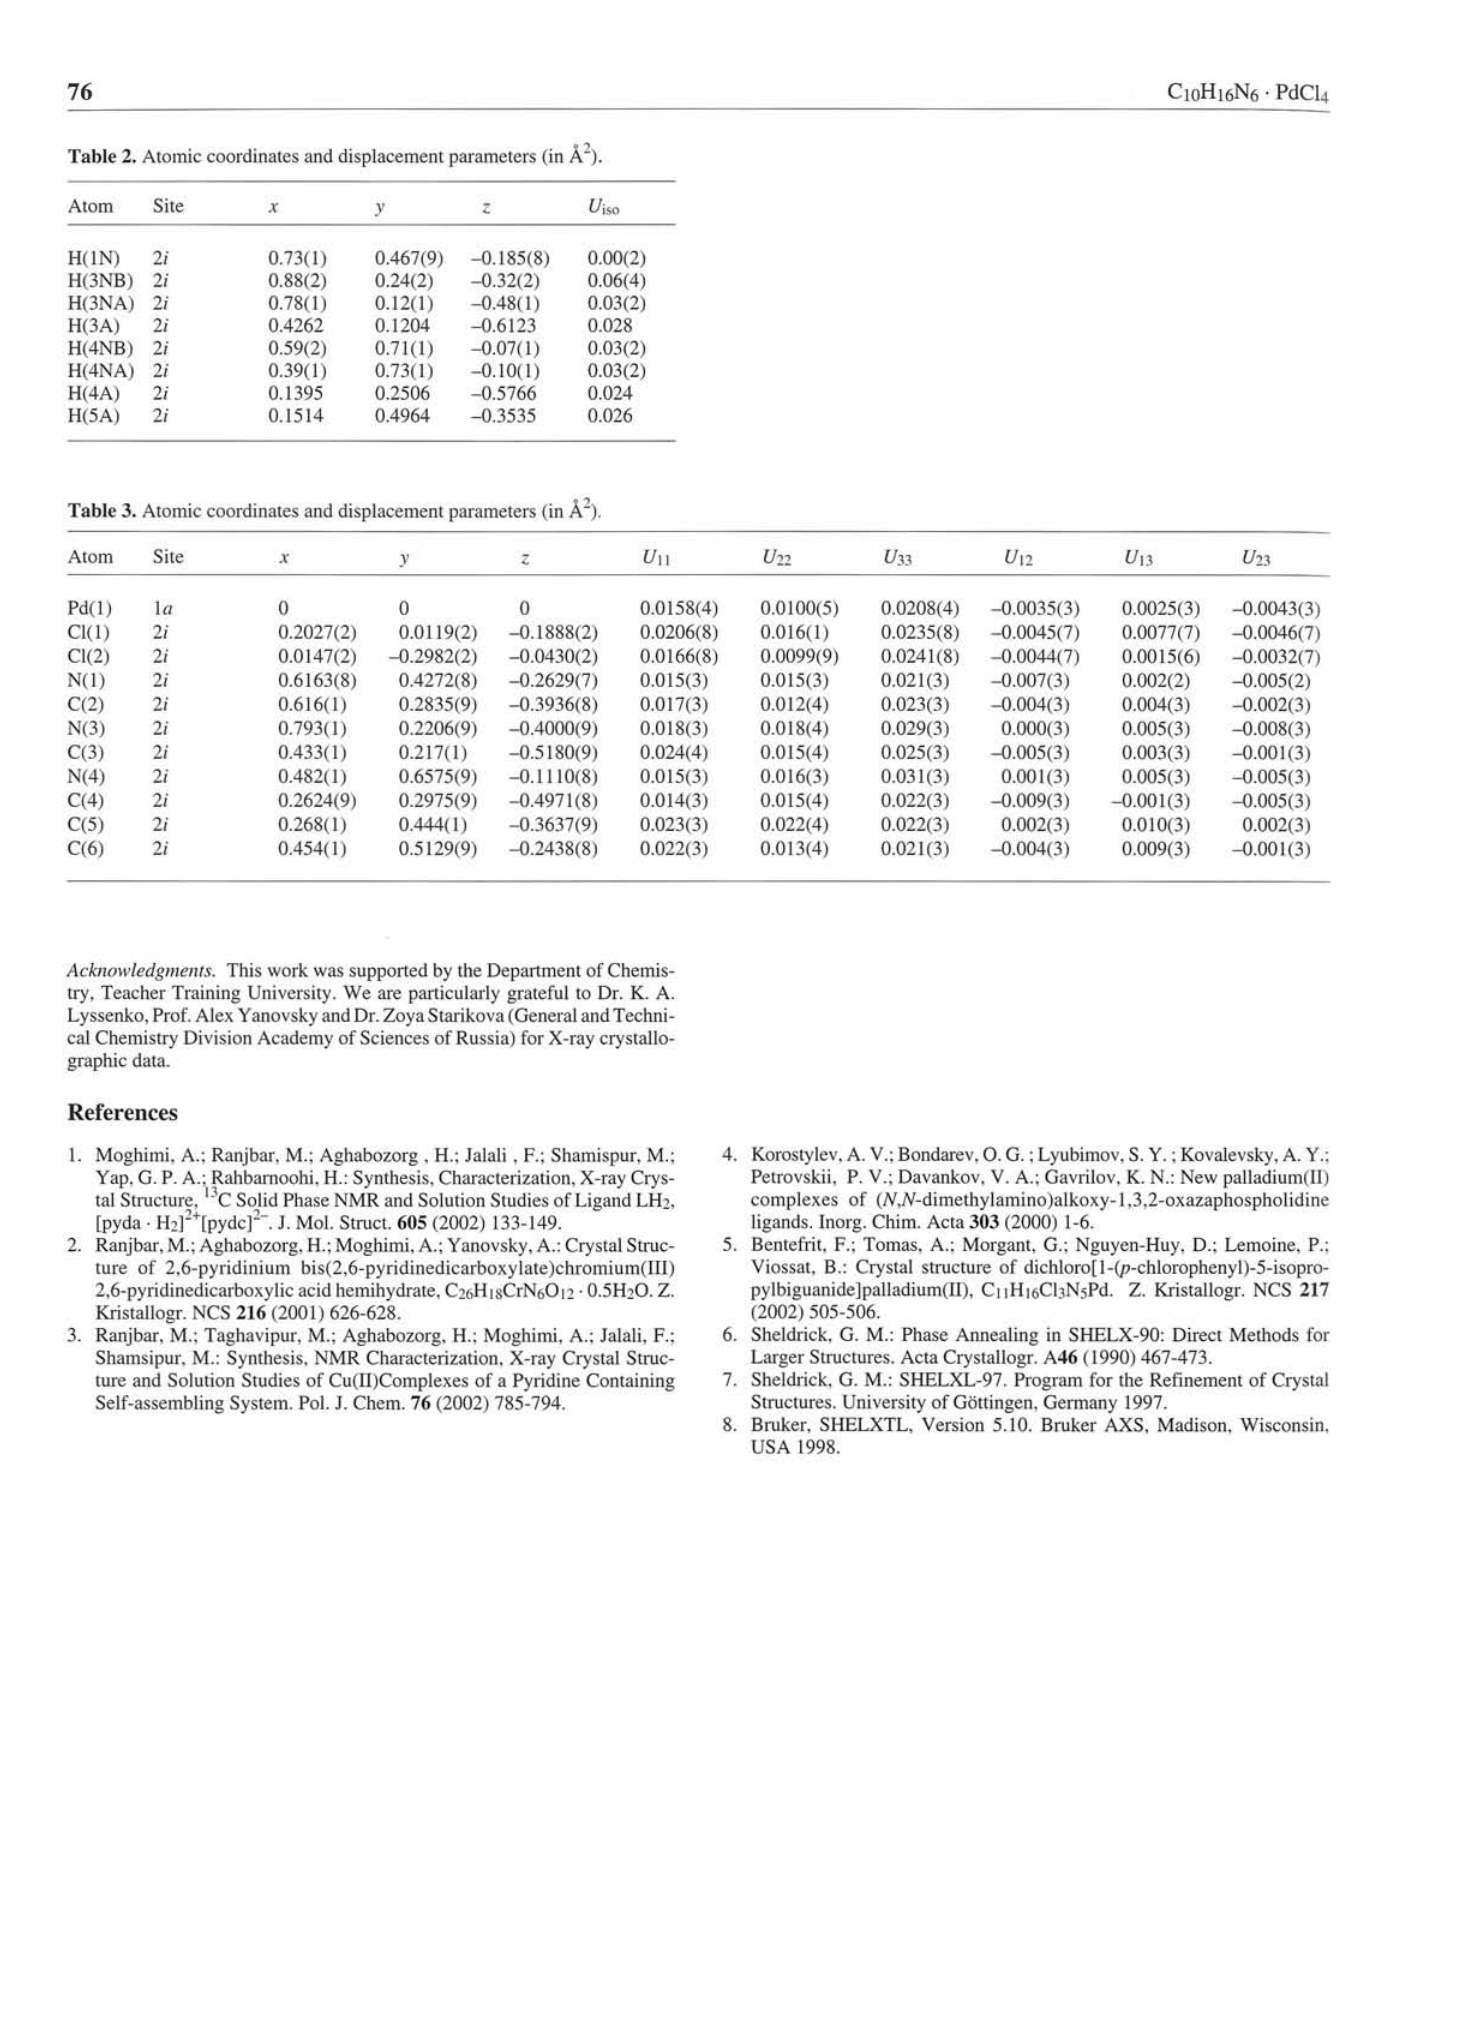
Table 3. Atomic coordinates and displacement parameters (in Â 2